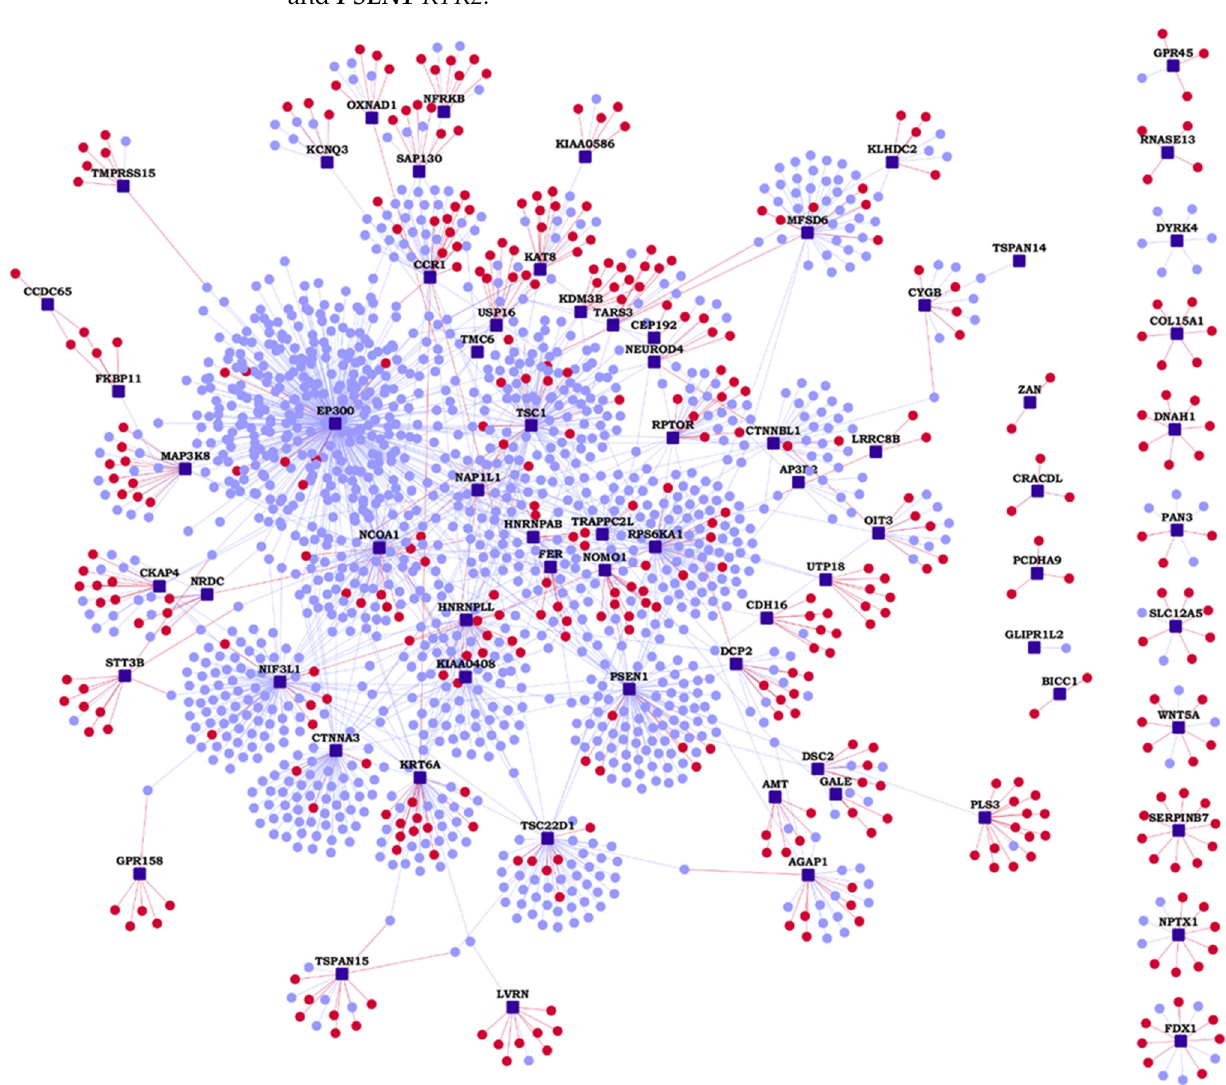
Figure 1. Hypoplastic left heart syndrome (HLHS) protein–protein interactome: Network view of the HLHS interactome is shown as a graph, where genes are shown as nodes and protein–protein interactions (PPIs) as edges connecting the nodes. HLHS-associated genes are shown as dark blue square-shaped nodes, novel interactors and known interactors as red and light blue colored circular nodes, respectively. Red edges are the novel interactions, whereas blue edges are known interactions.